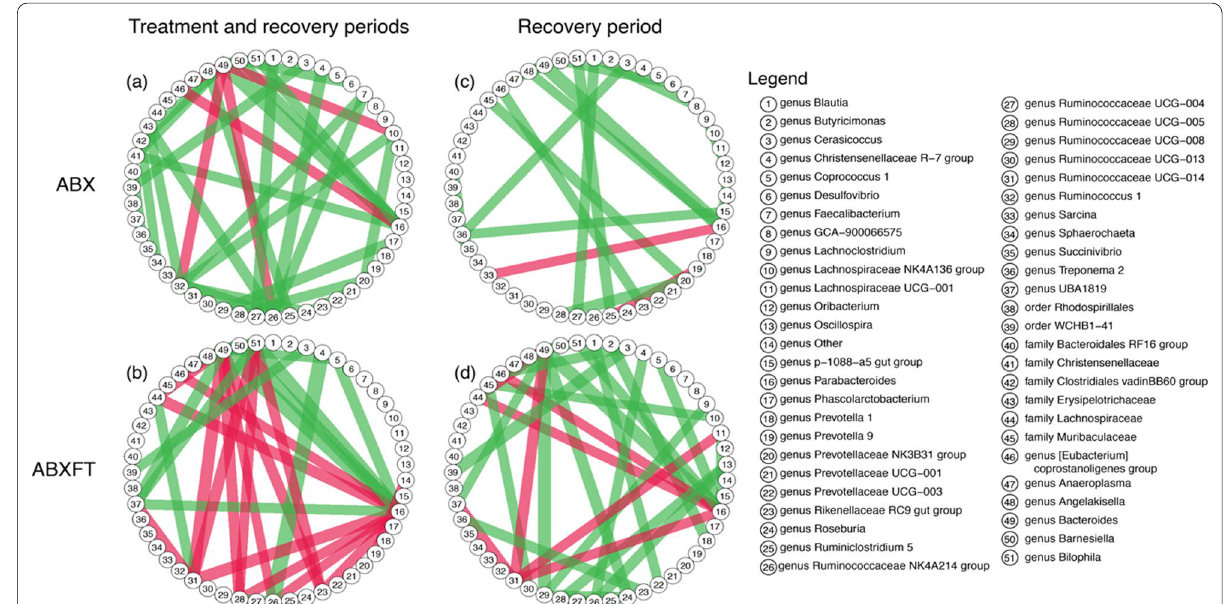
Fig. 4 Bacterial associations for healthy, male ring‑tailed lemurs ( Lemur catta ) either treated with antibiotics only (ABX) or with antibiotics plus a fecal transfaunation (ABXFT). Line colors represent the direction of the correlation (green magnitude of the correlation